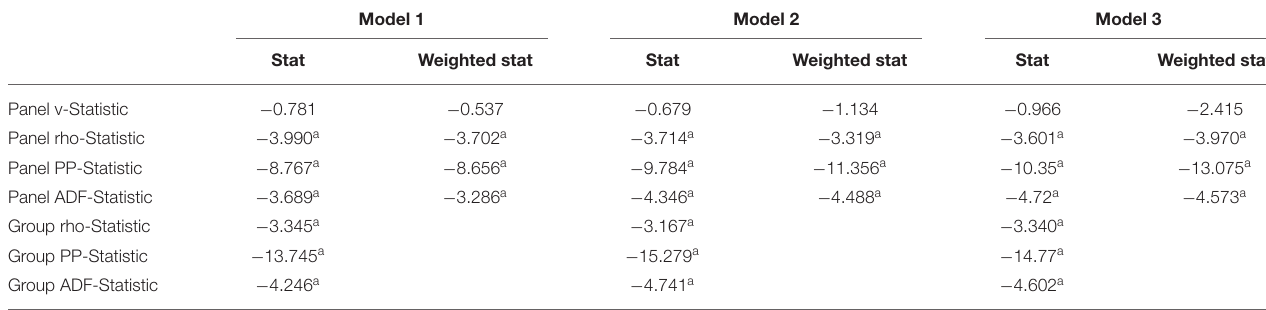
TABLE 6 | Pedroni cointegration.